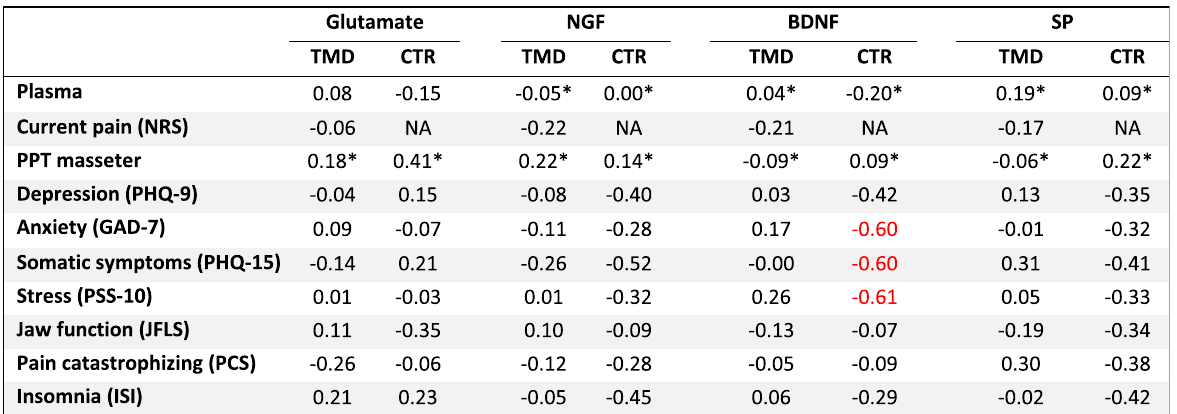
Table 2 Correlation coefficient matrix. Overview of correlations for salivary glutamate, nerve growth factor ( β NGF), brain derived neurotrophic factor (BDNF), and substance P (SP) in patients with temporomandibular disorders myalgia (TMD) and healthy controls (CTR). All correlations have been adjusted for multiple comparisons according to Bonferroni. Statistical analyses were performed with Pearson or Spearman* correlations test. Red marked correlations denote